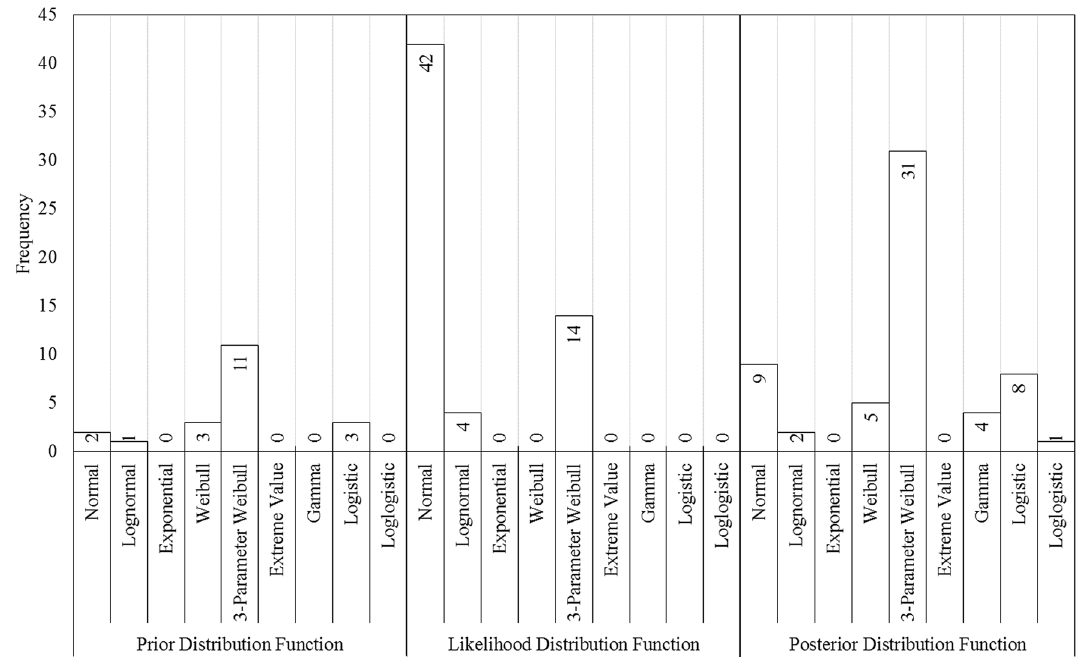
Figure 4. The frequency of using each individual theoretical pdf s as prior, likelihood function, and posterior distributions.